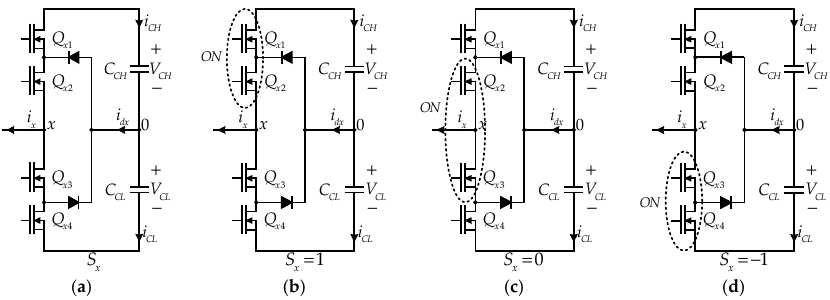
Figure 1. The switching leg of the three-level neutral-point-clamped (NPC) inverter and its switching states. ( a ) The circuit structure; ( b ) the conduction state with S x = 1; ( c ) the conduction state with S x = 0; and ( d ) the conduction state with S x = −